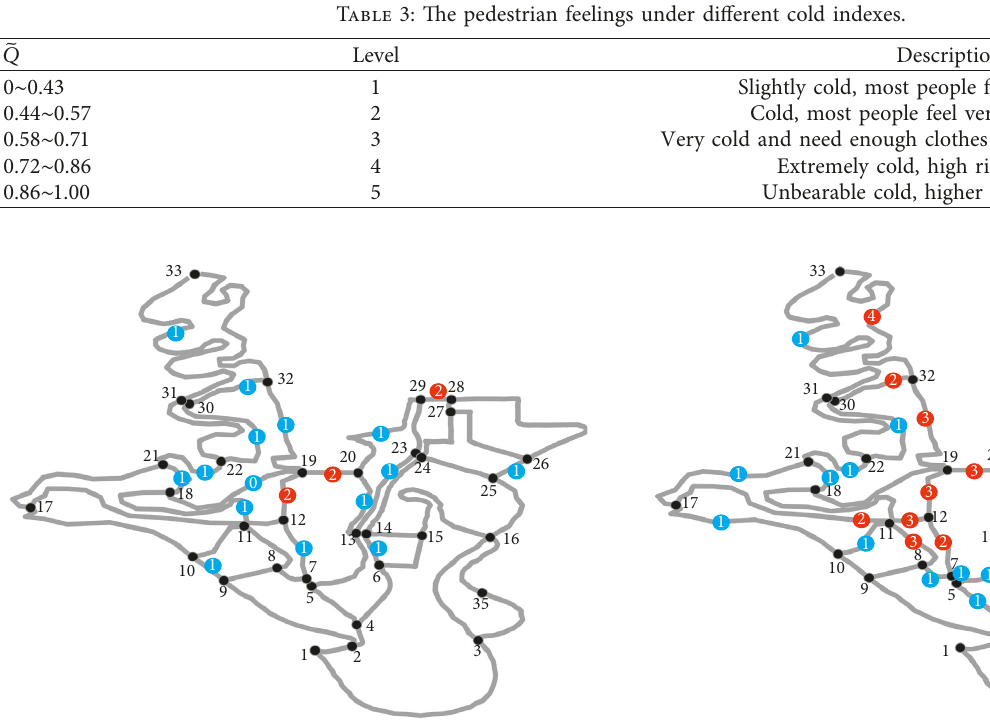
Figure 16: VMS information release times of each road section for the scenario of